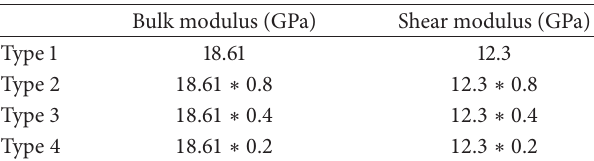
Table 1: Properties of four types of ITZs between the deposition products inclusion and the concrete.